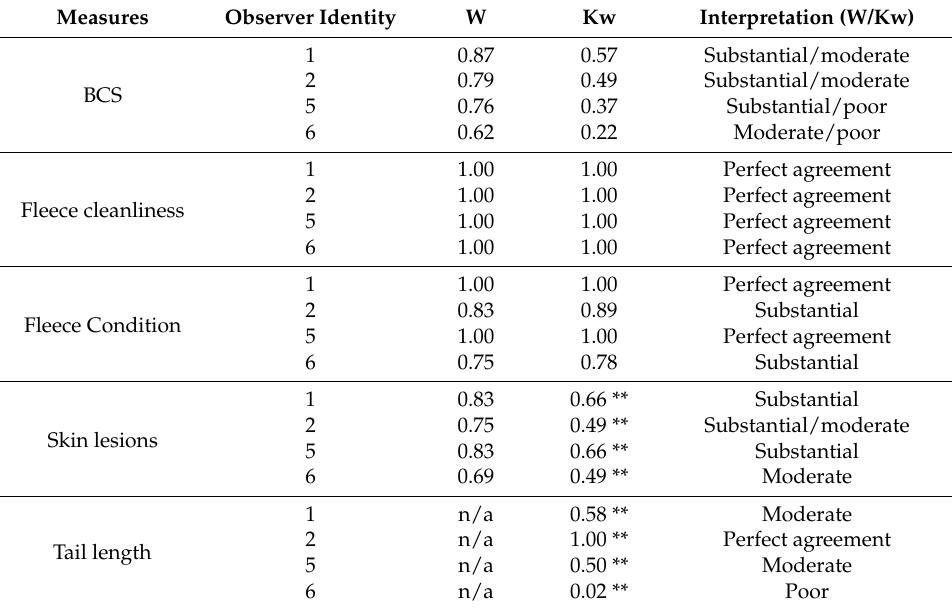
Table 5. Intra-observer agreement at